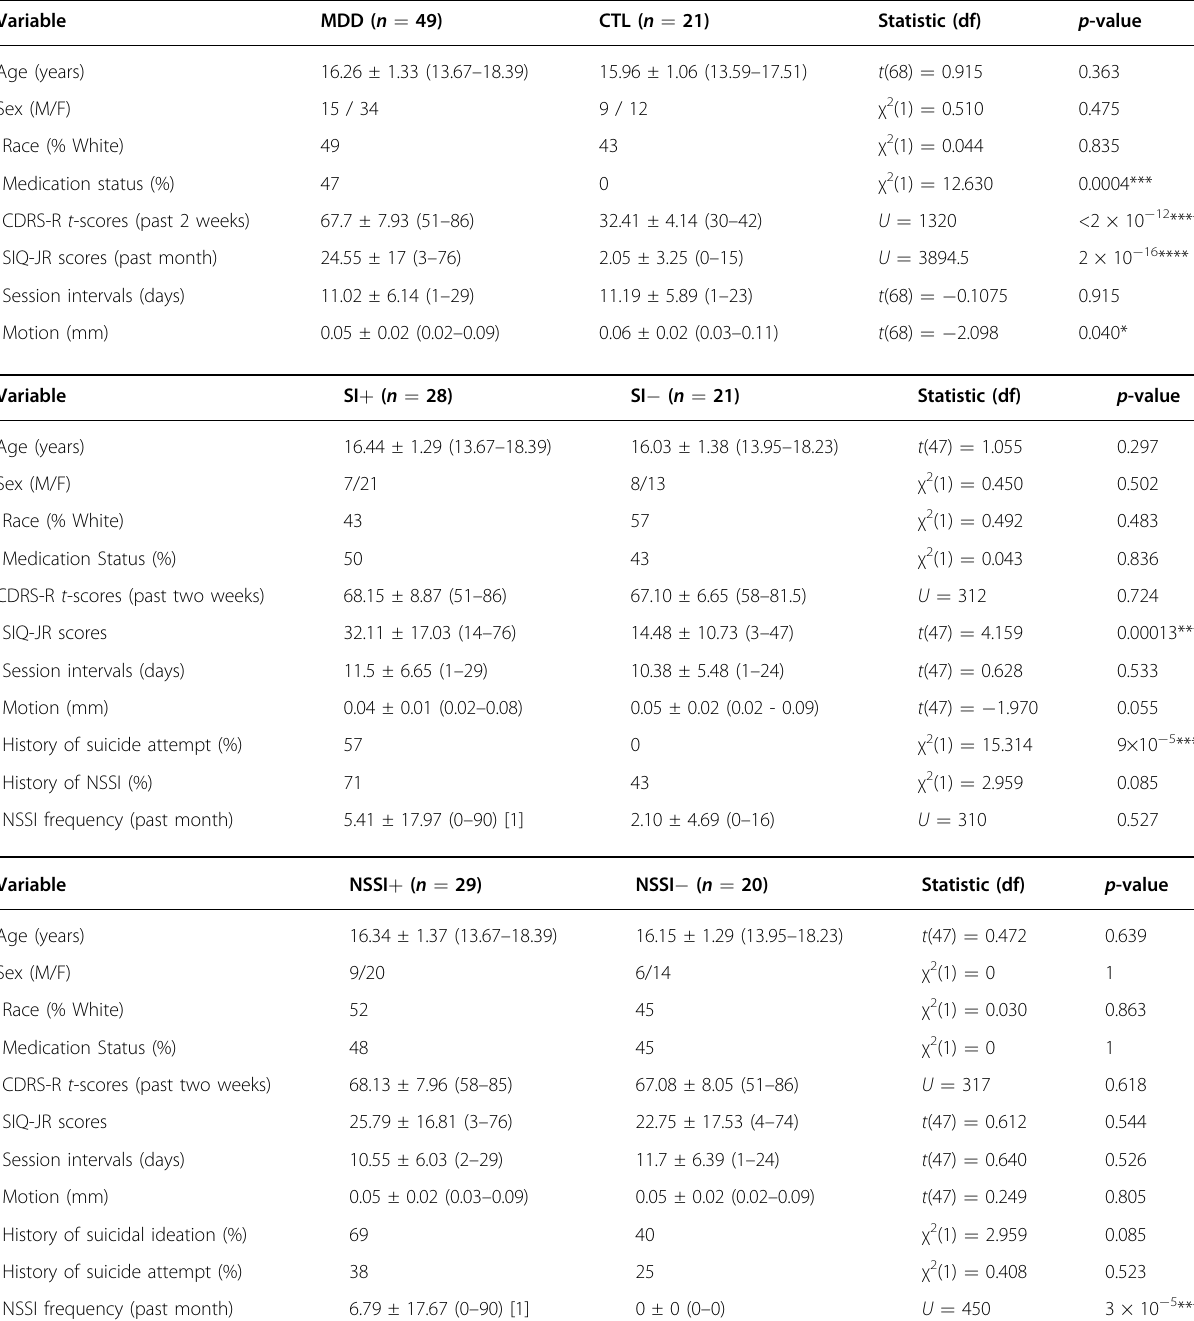
Table 1 A. Descriptive statistics for depressed and non-depressed adolescents. B. Descriptive statistics for depressed with suicidal ideation (SI + ) and without suicidal ideation (SI − ). C. Descriptive statistics for depressed with non-suicidal self-injury (NSSI + ) and without non-suicidal self-injury (NSSI −